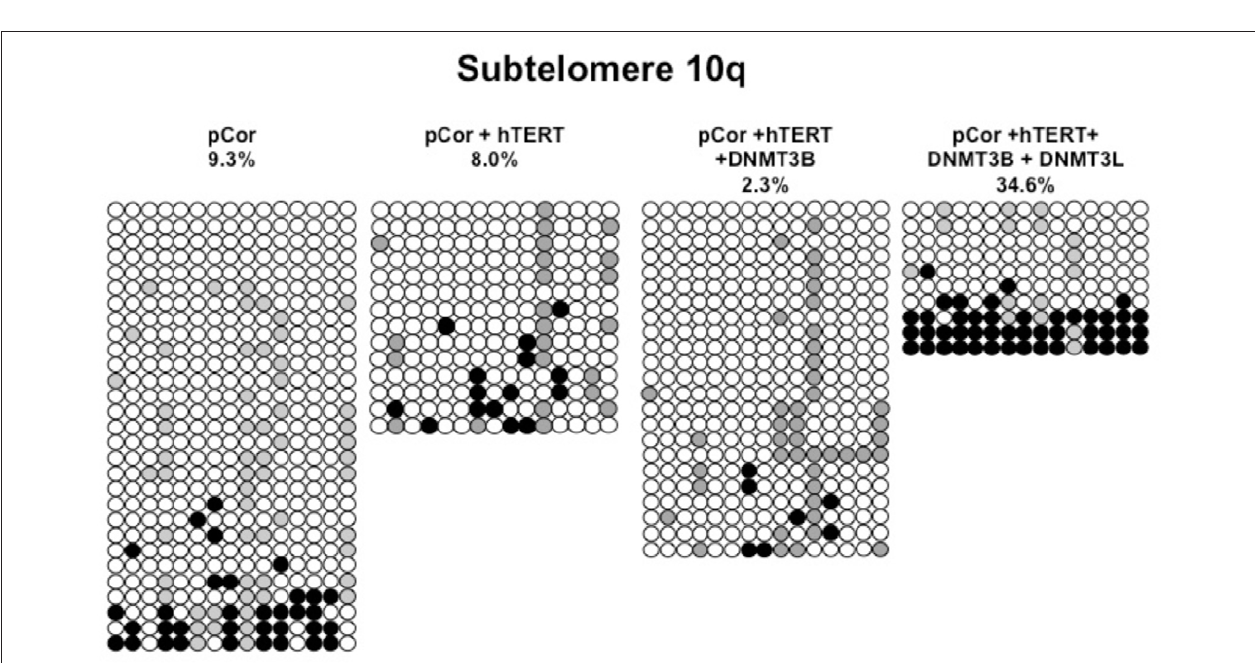
dinucleotides and black circles represent methylated CpG dinucleotides. Gray circles represent CpG sites that were converted to CpA or TpA, as occasionally can be observed. Each row is derived from an individual subclone. Percent of CpG methylation appears below the cell type.